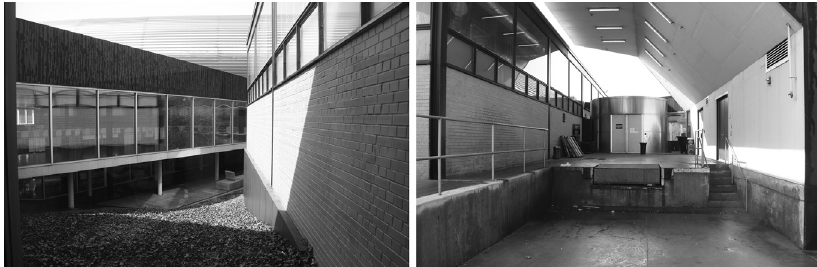
Figure 2. The MTCC as a “frame” for the Commons Building. At left, the interior courtyard of the MTCC with the south wall of the Commons Building visible at right; at right, the MTCC loading dock with its roof extending over the west wall of the Commons Building, visible at left. Photographs by Author,